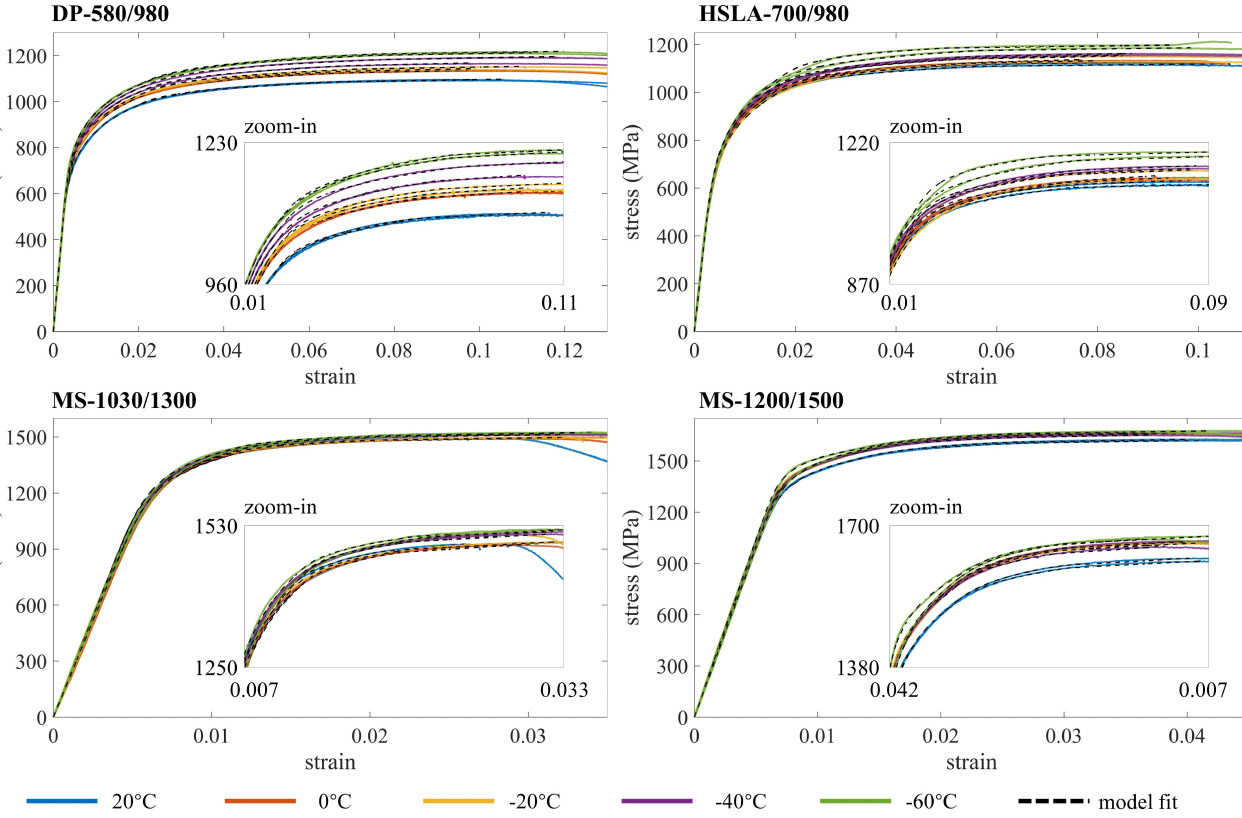
Figure 6. Experimental stress-strain curves from the steady-state subzero temperature tests with the fit between the test curves and the two-stage plus linear model for AHSS and HSLA steel.